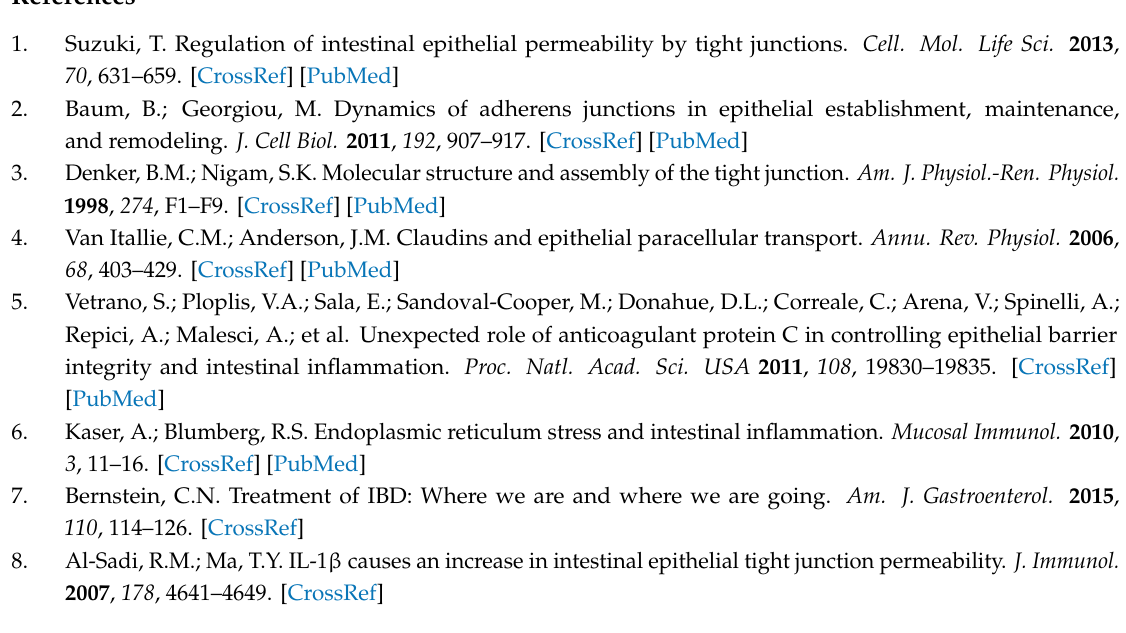
Figure S1: Viability of the three commensal bacteria species in bacteria culture medium and cell culture medium. F. prausnitzii , B. faecis and R. intestinalis in stationary phase suspended in anaerobic DMEM (CM) and supplemented YBHI (BM) and incubated anaerobically at 37 ◦ C for 12 h. The optical density (OD600nm) was measured every 2 h over the period of 12 h. Results are represented as the mean of triplicate experiments ±